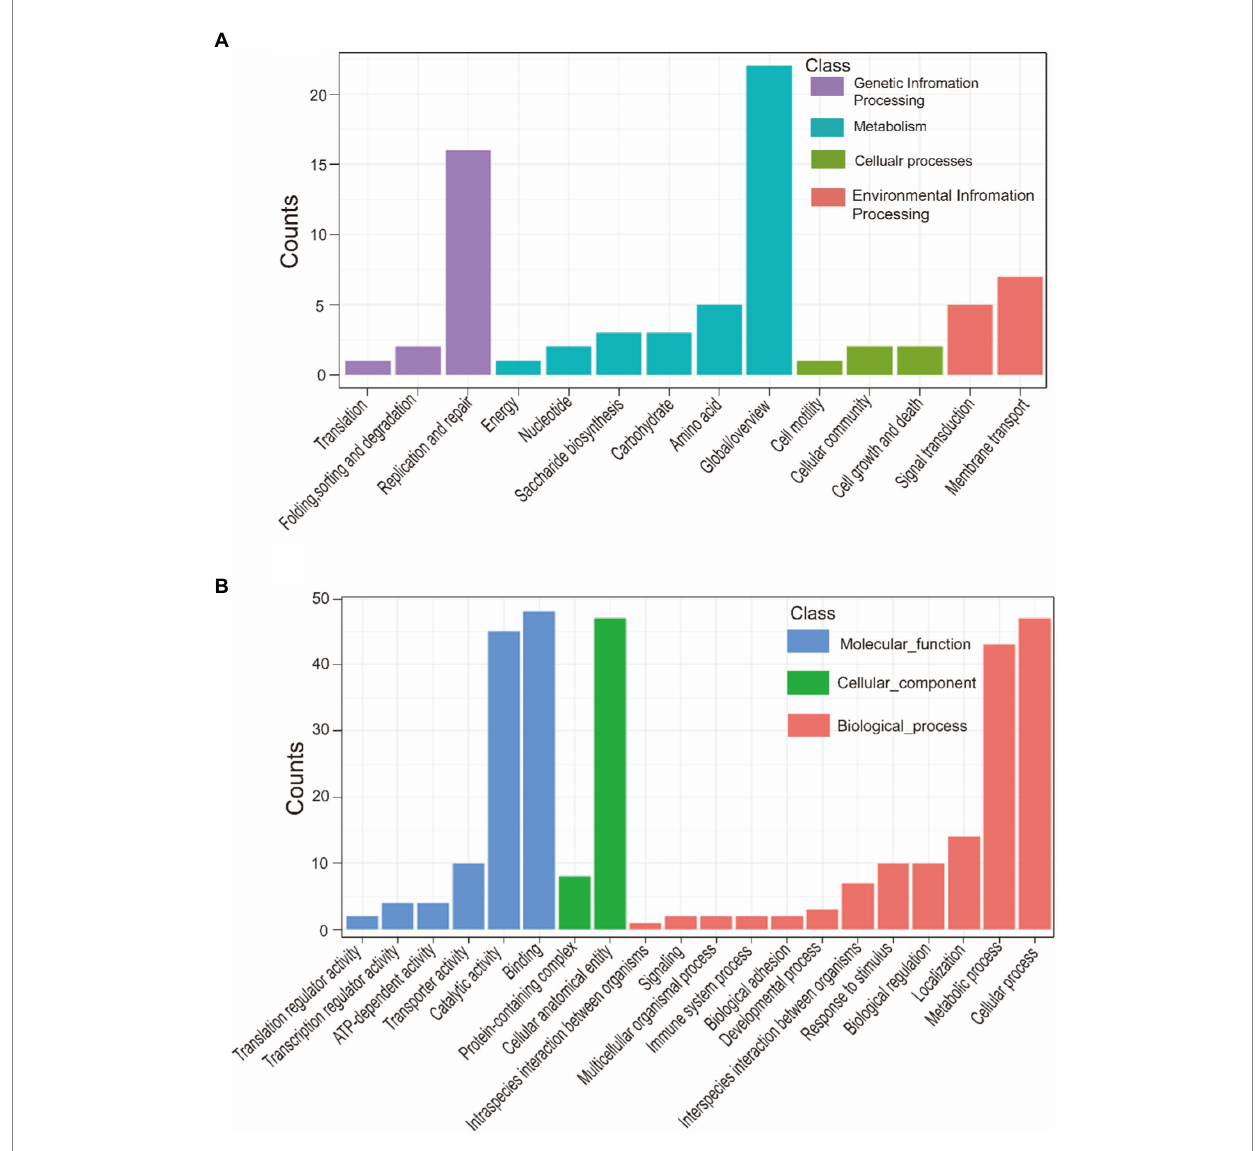
FIGURE 7 KEGG annotation of strong virulence-associated genes (A) . GO annotation of strong virulence-associated genes (B)